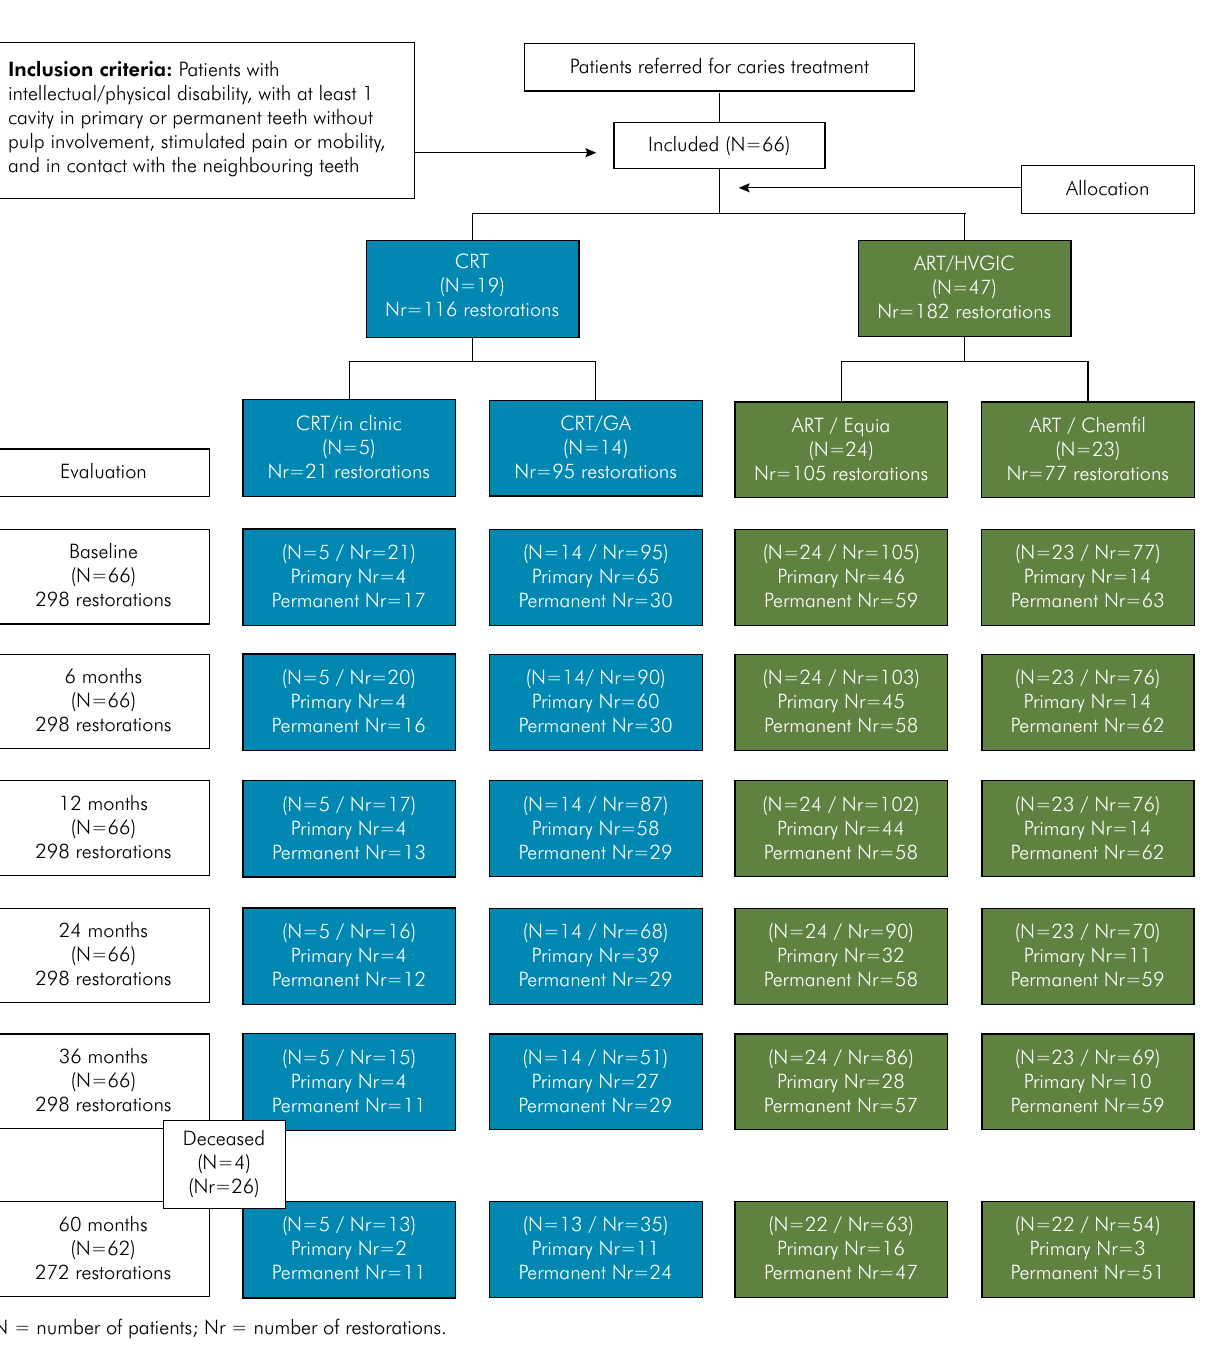
Figure. Flow-chart of the 5-year follow-up of patients with disability that received ART and CRT